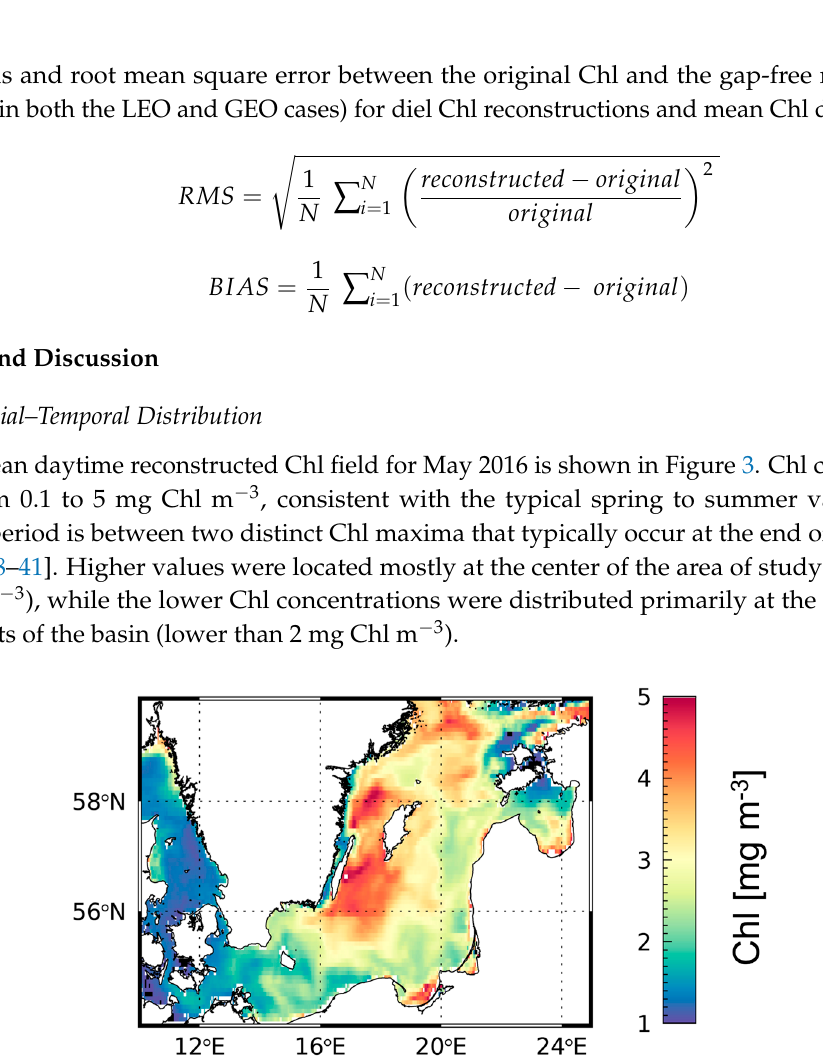
Figure 3. The mean daytime Chl field for May 2016 from the biogeochemical model after reconstruction of gaps with the Multi-Channel Singular Spectral Analysis (M-SSA) method using observations from a geostationary (GEO) simulation.